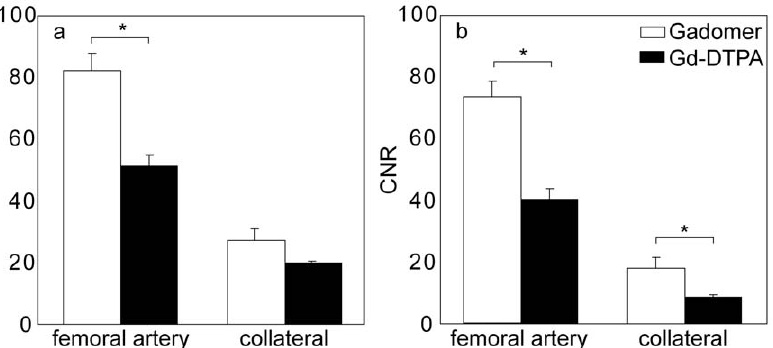
Figure 2. SNR and CNR in femoral and collateral artery. Mean signal-to-noise (SNR, panel a) and contrast-to-noise ratio (CNR, panel b) in the femoral artery and a collateral artery originating from the deep femoral artery in the steady-state MR angiograms for Gadomer (white) and Gd-DTPA (black). Error bars indicate standard error of the mean. Significant differences between contrast agents ( p , 0.05) are indicated with *. Data were averaged over days 14 and 21 post ligation.